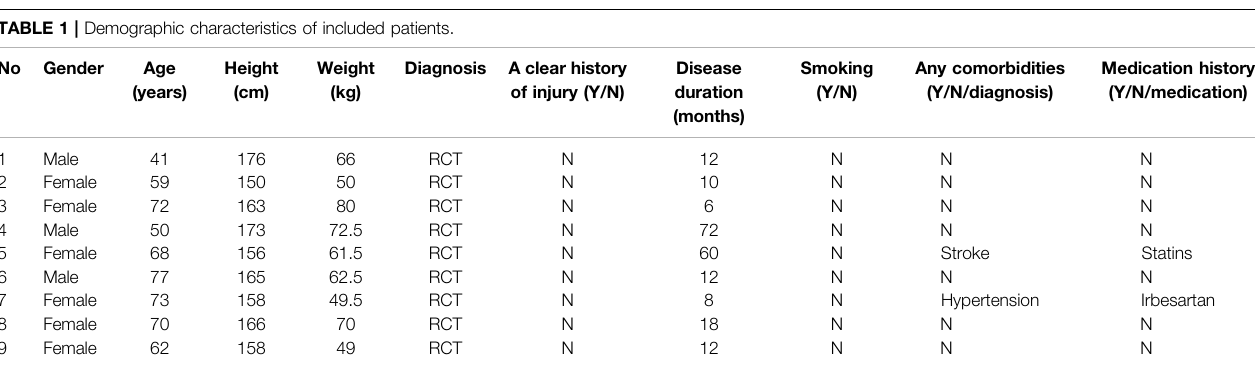
TABLE 1 | Demographic characteristics of included